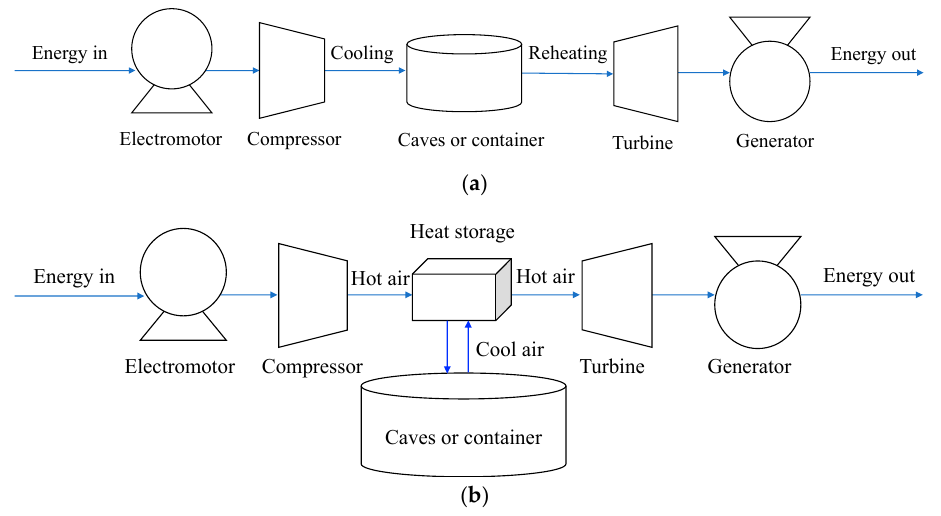
Figure 2. Structure of a CAES system: ( a ) without heat storage; and ( b ) with heat storage.